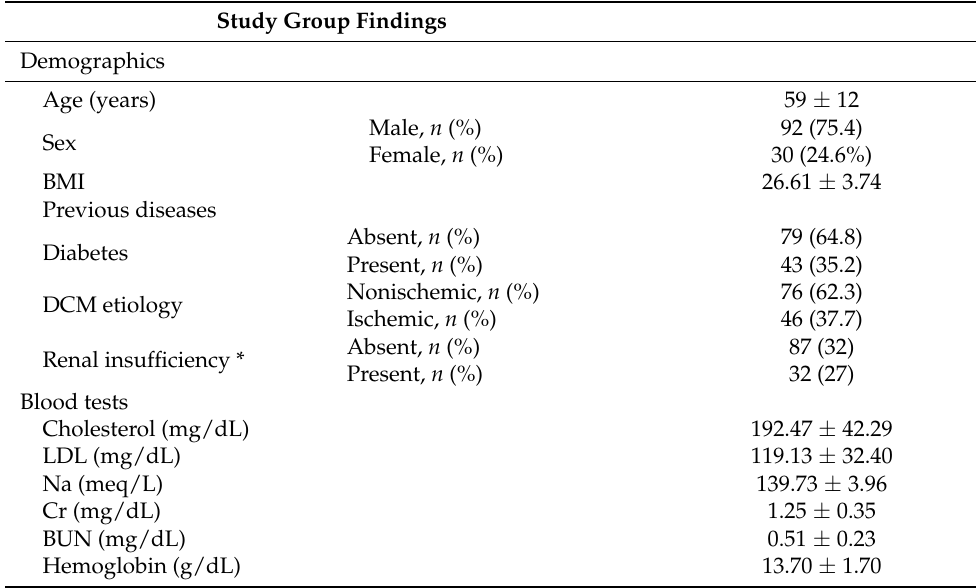
Table 1. Demographics, clinical, echocardiographic, and CPX findings. Study Group